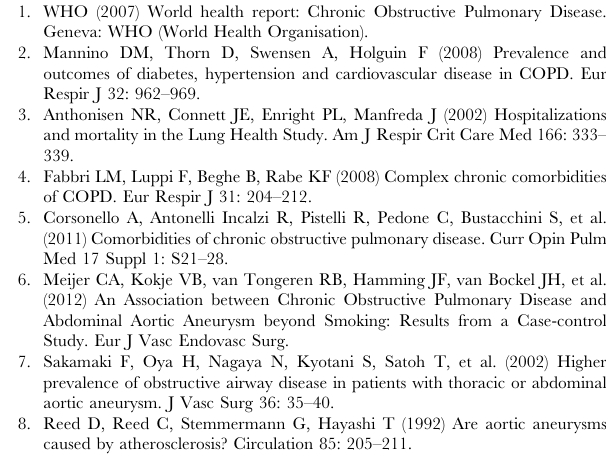
Table S6 Deregulated TGF- b pathway genes in adult and newborn Fibulin-4 deficient lungs compared to Fibulin-4 + / + lungs (p , 0.05). Table S7 Primers used for quantitative real time PCR. Forward and reverse primers are displayed for each gene from 5 9 to 3 9